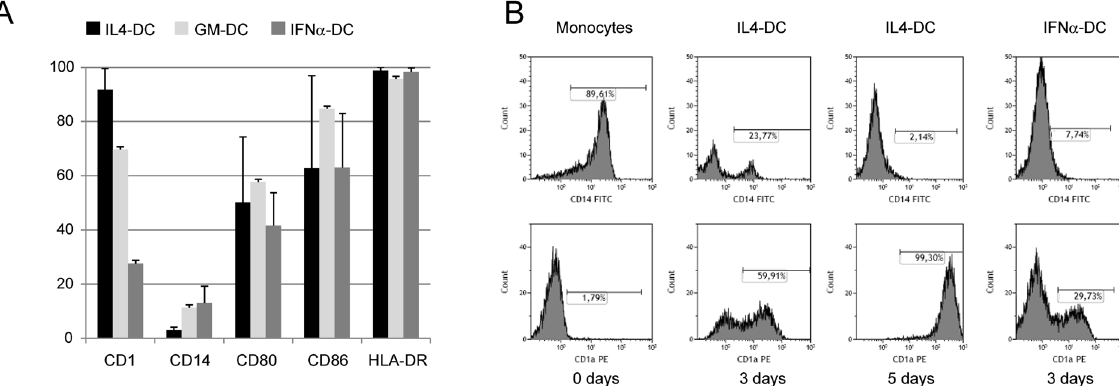
Figure 1. Evaluation of DC phenotype. ( A ) Mean and SD of percentage of surface antigens expressed by DC, generated using different culture conditions. Monocyte-derived DC generated after incubation with GM- CSF and IL-4 (black column) or GM-CSF alone (light grey column) were evaluated after 5-day culture. DC generated after incubation with GM-CSF plus IFN α (dark grey column) were evaluated after 3-day culture. ( B ) Representative flow histograms of CD1a and CD14 expression in fresh monocytes, after 3 and 5 days incubation with GM-CSF plus IL-4, or 3 days with GM-CSF plus IFN α . Percentages of positive cells were evaluated by subtracting values obtained from unmarked cells used as negative